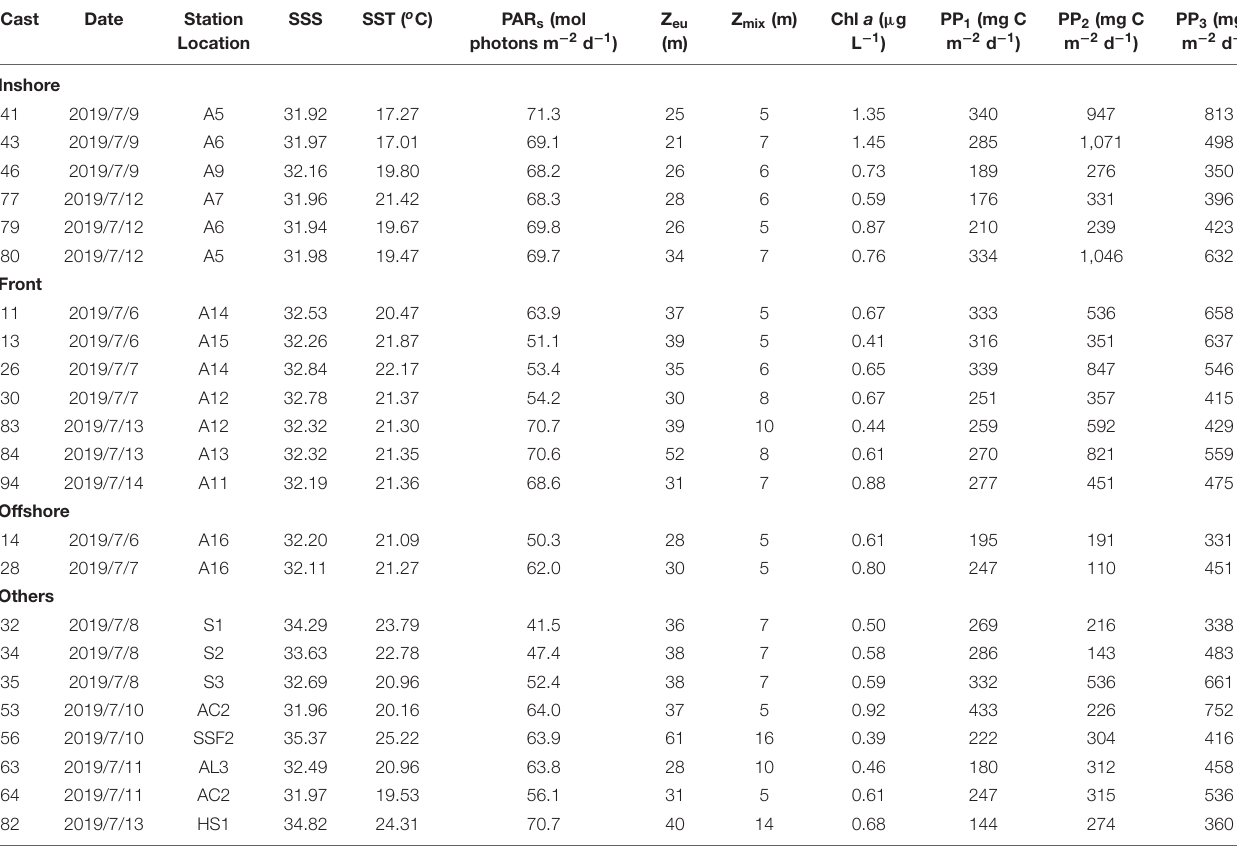
TABLE 4 | Primary productivity during